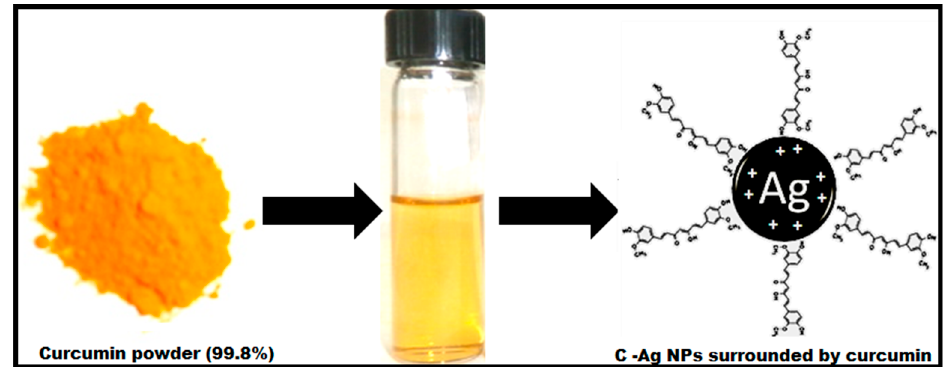
Figure 1. An illustration showing the formation of curcumin silver nanoparticles (C-Ag NPs) surrounded by curcumin.